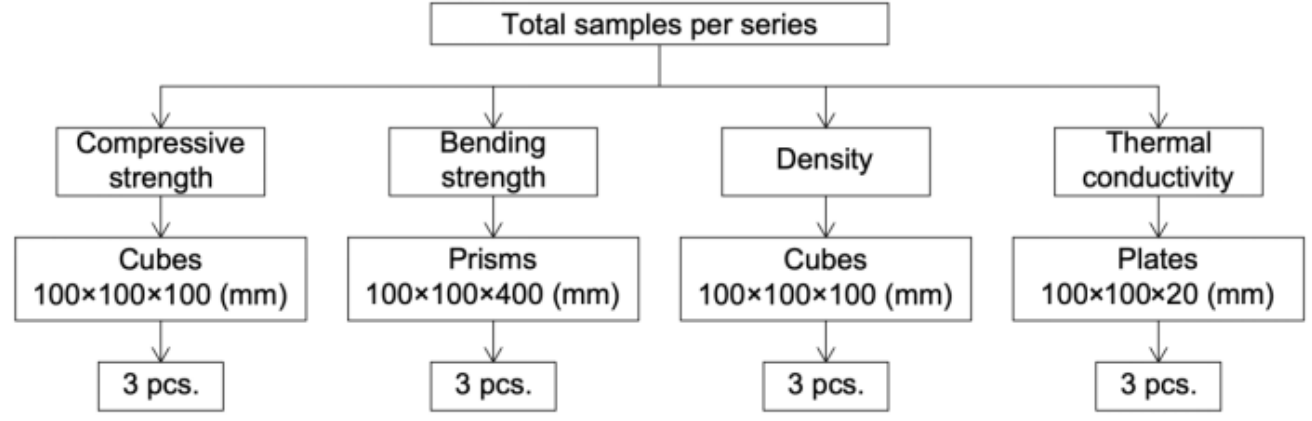
Figure 4. Types of tests and the number of samples of fiber-reinforced concrete at the second stage of the study.